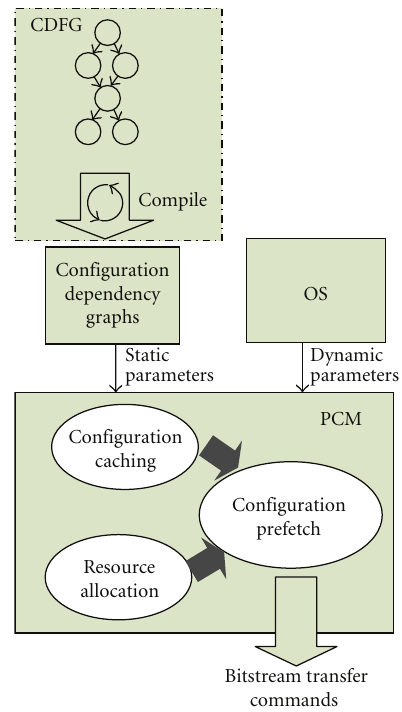
Figure 4: Principle of the reconfiguration